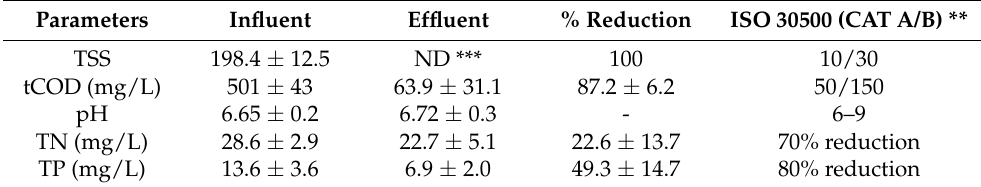
Table 3. Summary of the system performance compared to ISO 30500 liquid effluent standards for chemical parameters over the pseudo-steady state period (first 50 days excluded)